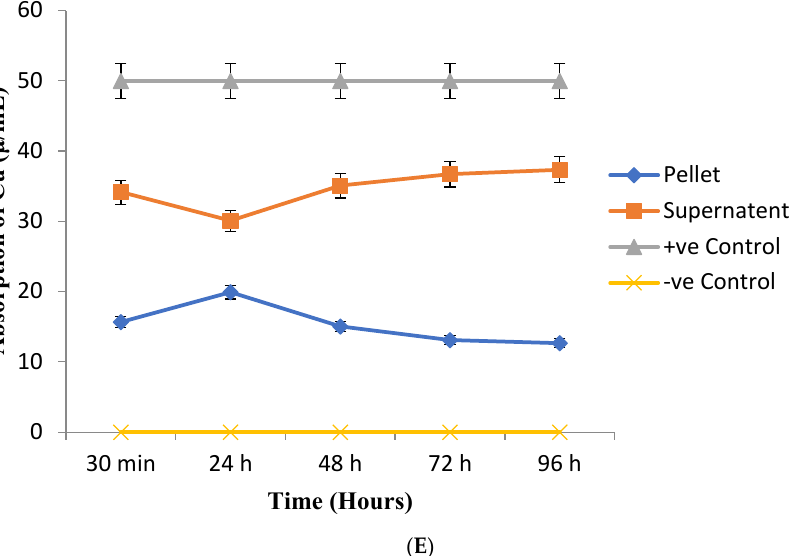
Figure 4. Uptake of copper ions from culture medium by Paramecium multimicronucleatum at concentrations of ( A ) 10 μ g/mL, ( B ) 20 μ g/mL, ( C ) 30 μ g/mL, ( D ) 40 μ g/mL, and ( E ) 50 μ g/mL.